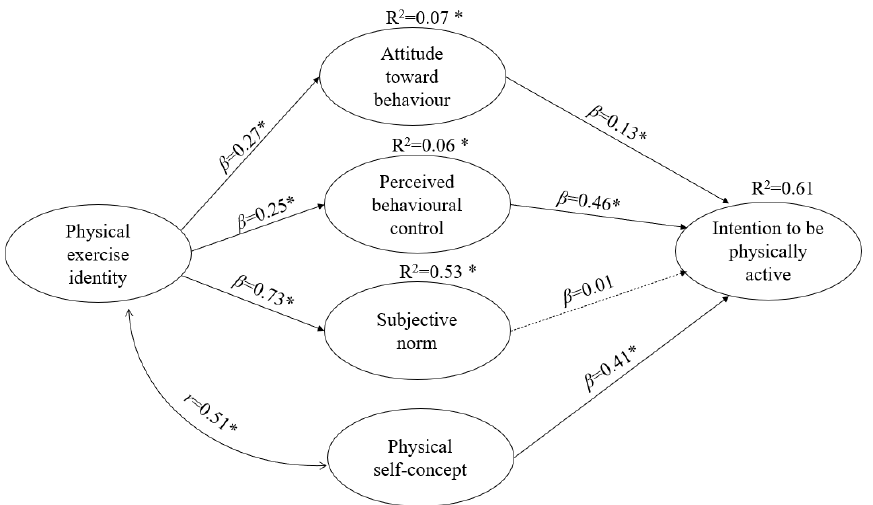
Figure 2. Model of causal relationships influencing students’ IPA after completing secondary school and TPB variables, AI and PSC Note: * p < 0.05. Model fit: χ (gl) = 247.54 (127); S - B χ (gl) = 213.16 (127), NNFI = 0.94, CFI = 0.95, RMSEA = 0.06 (0.03 –0.08). The discontinuous line indicates a non-significant relationship.